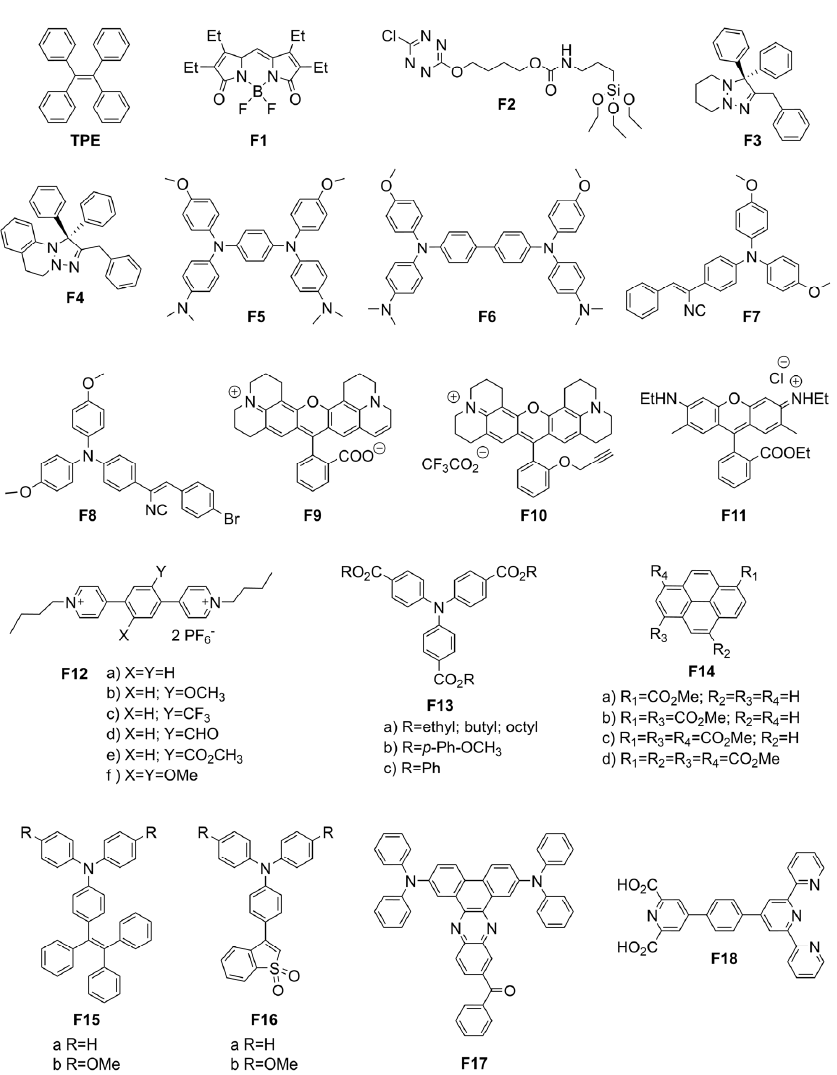
Figure 8. Representative examples of consolidated intrinsically electroactive organic fluorophores used as EFC materials [87–99].